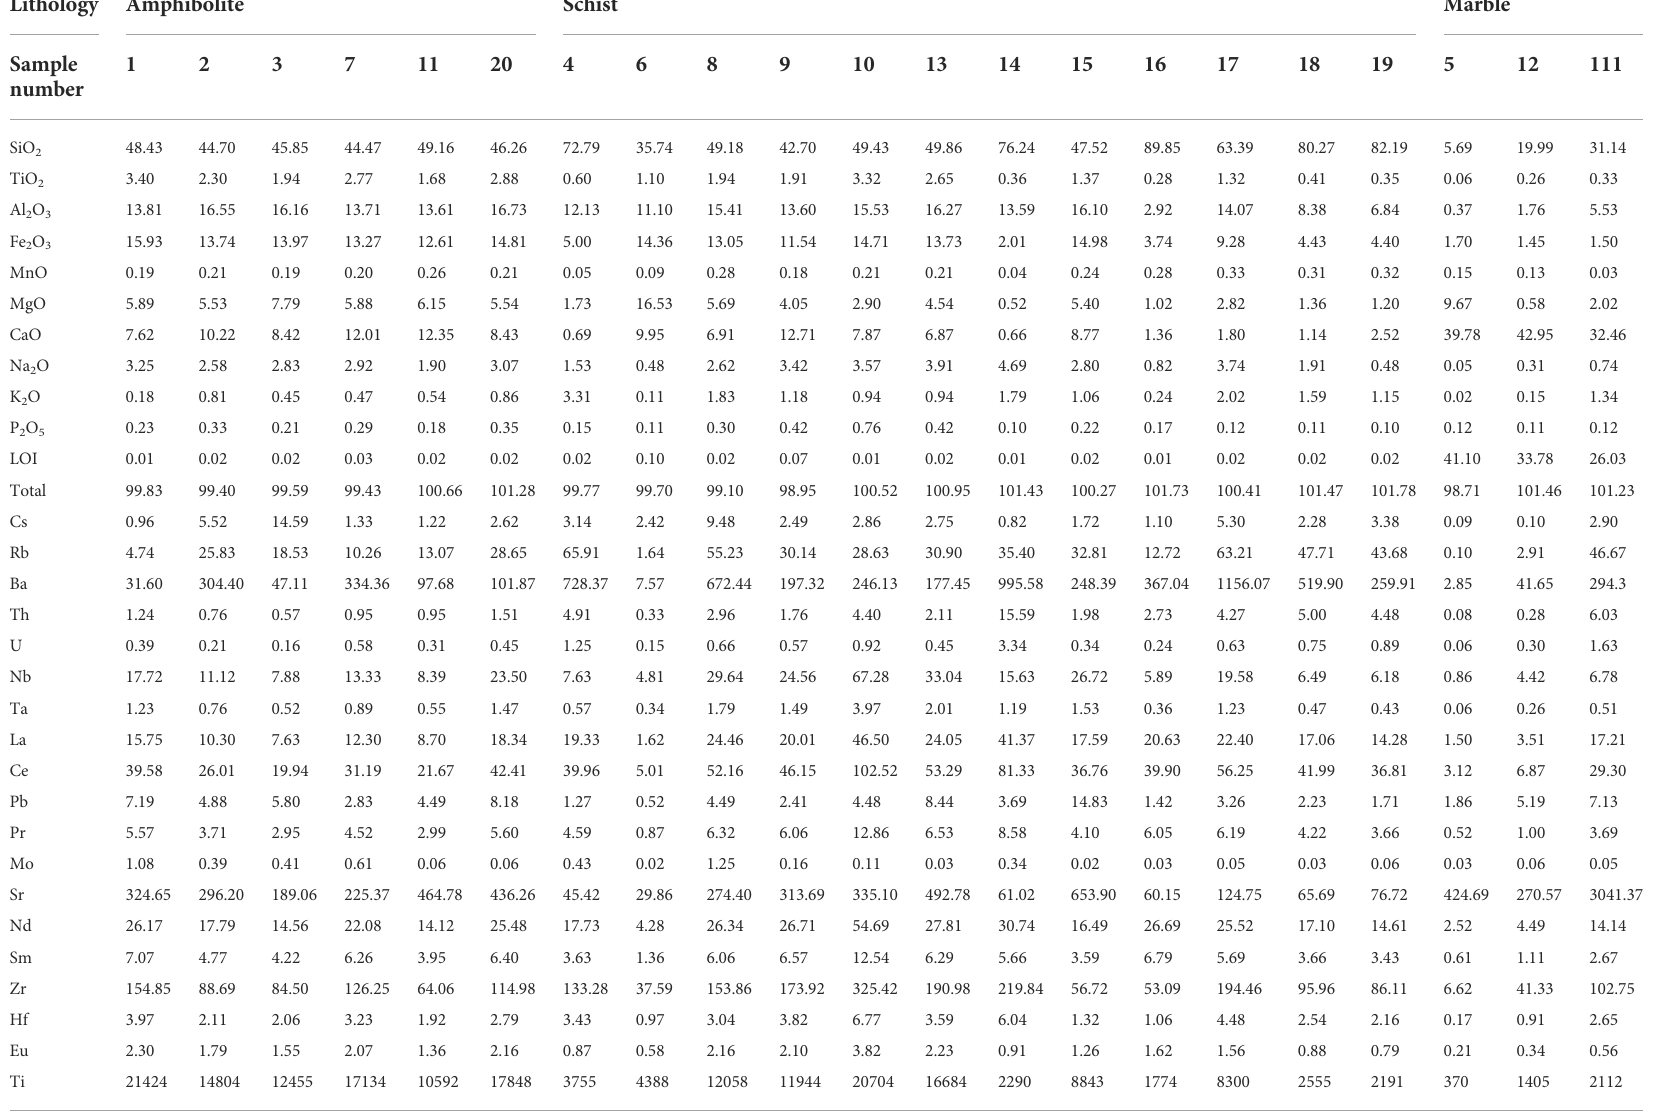
TABLE 2 Major element contents (wt.%) and trace element contents (ppm) of metamorphic rocks from the Xunyangba area in this study. Lithology Amphibolite Schist